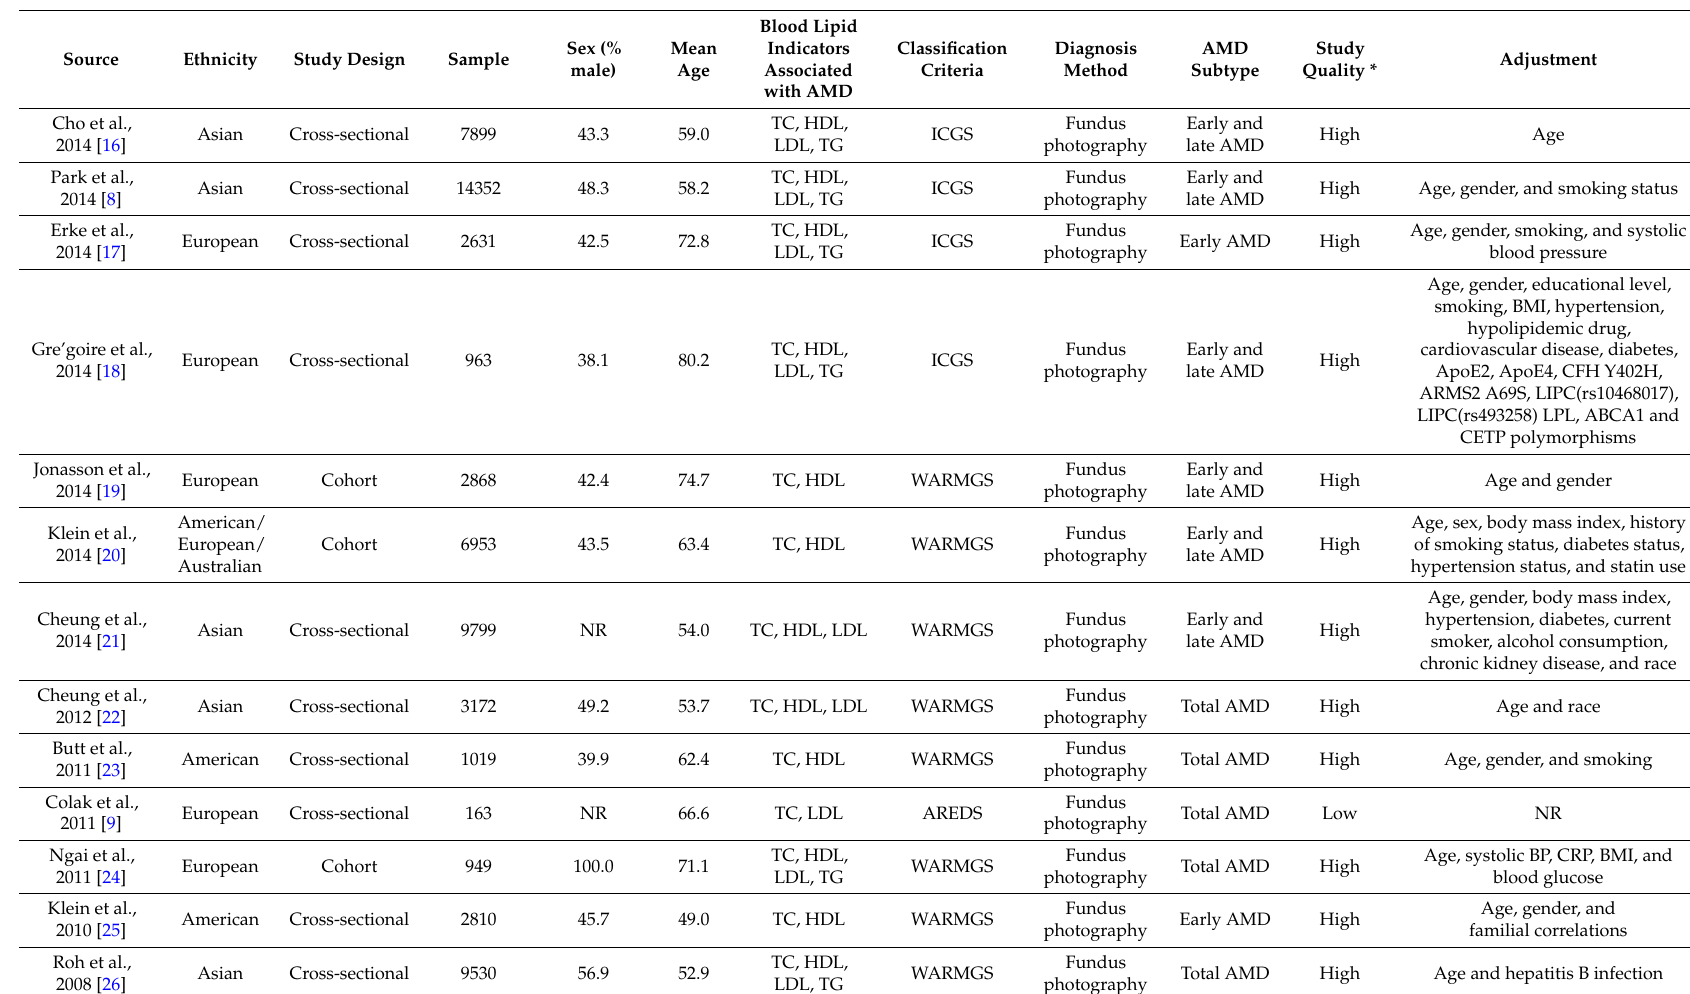
Table 1. Characteristics of studies included in this meta-analysis of blood lipids and age-related macular